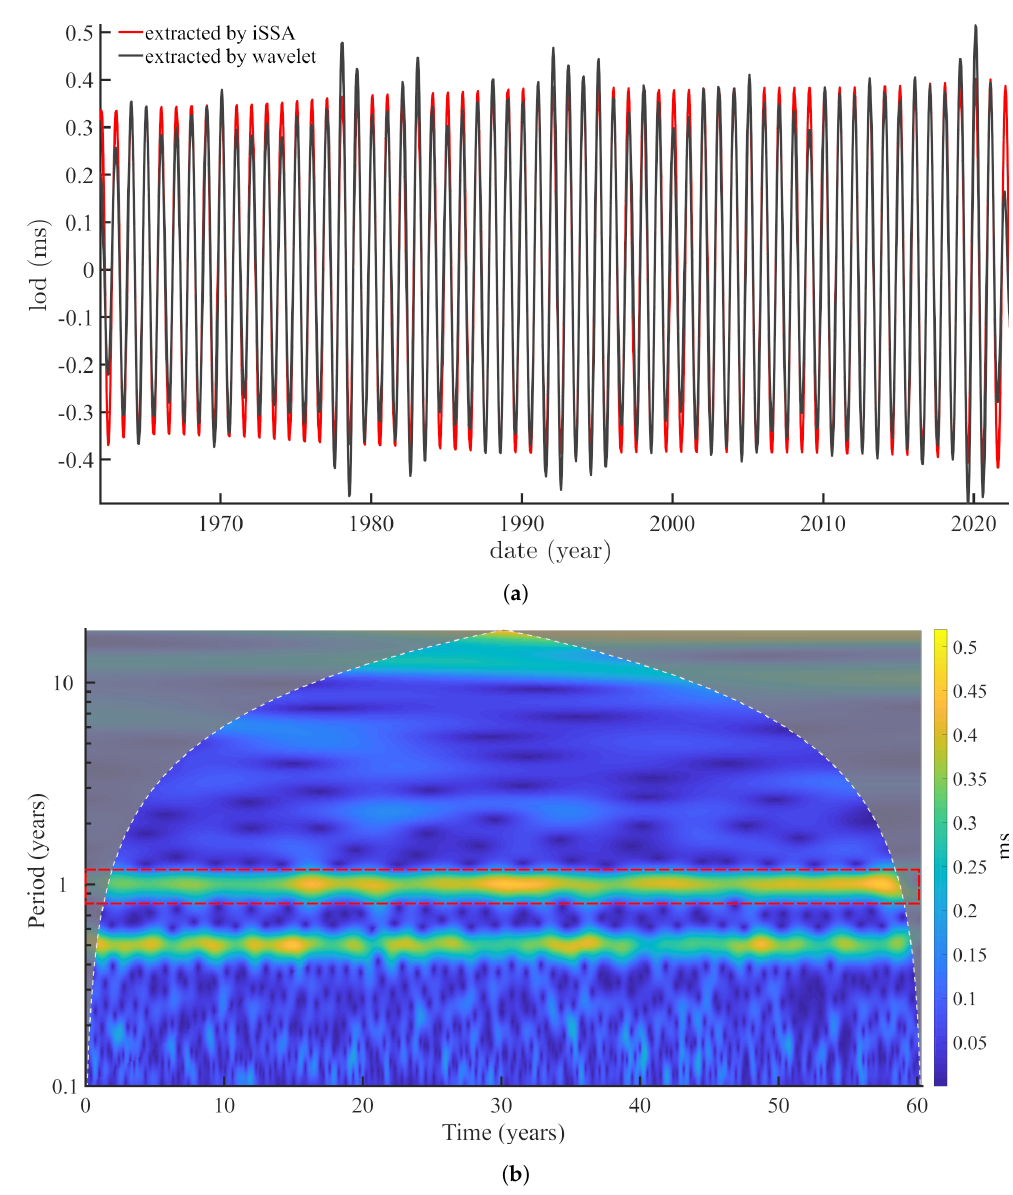
Figure 3. Extraction of oscillatory component by continues wavelet transform: an example. ( a ) Black curve: annual component of lod extracted by the method of continuous wavelets; Red curve: annual component of lod extracted by the iSSA method. ( b ) Scalogram of lod since 1962. The wavelet cone of influence is symbolized by the gray area. The red dashed lines enclose the wavelet coefficients corresponding to the 1 year